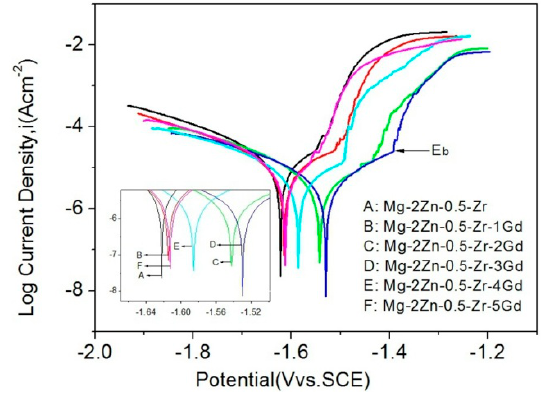
Figure 9. Polarization curves of the Mg–2.0Zn–0.5Zr–xGd alloys. Table 2. E corr , I coor , and P i of Mg–2.0Zn–0.5Zr–xGd alloys derived from the polarization curves.